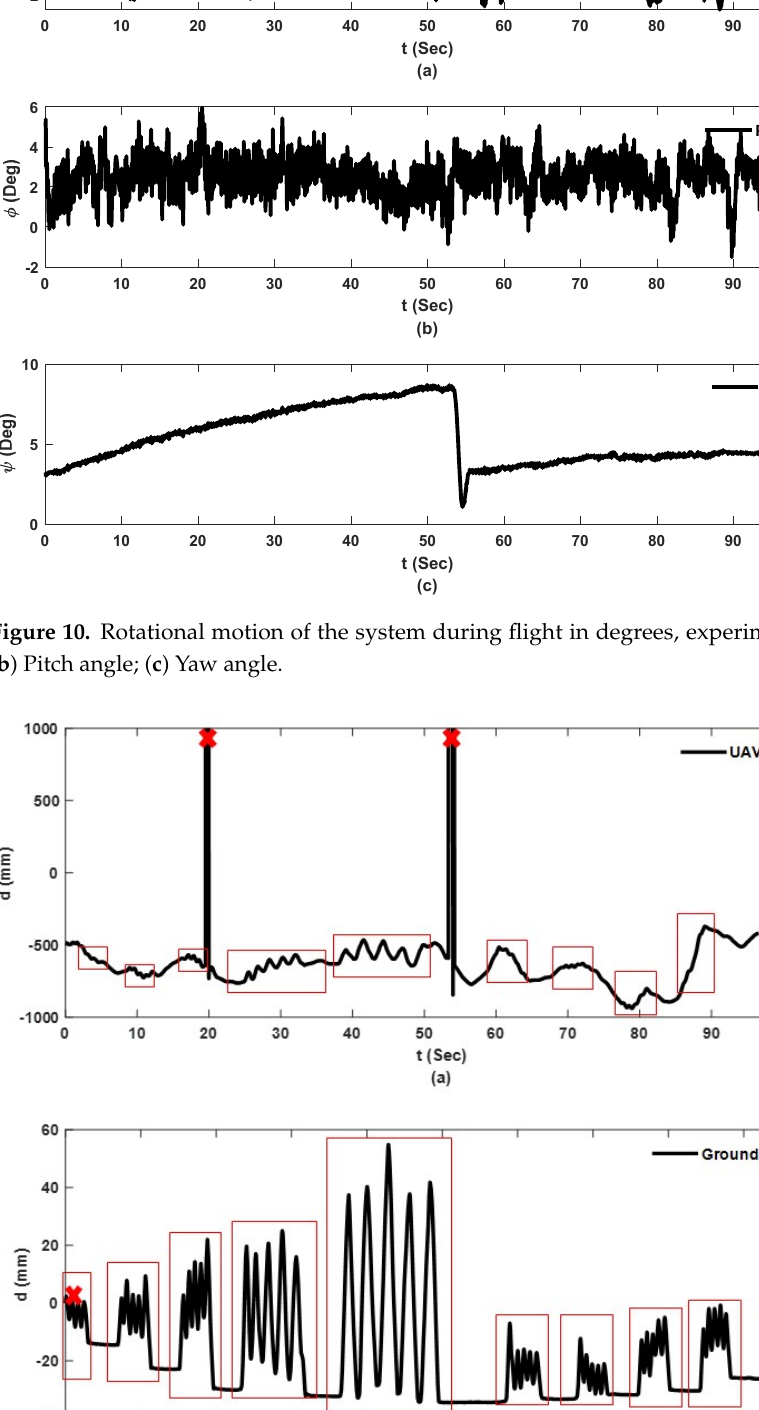
Figure 11. Laser’s raw data, experiment 2: ( a ) Hovering laser on UAS; ( b ) Ground laser.